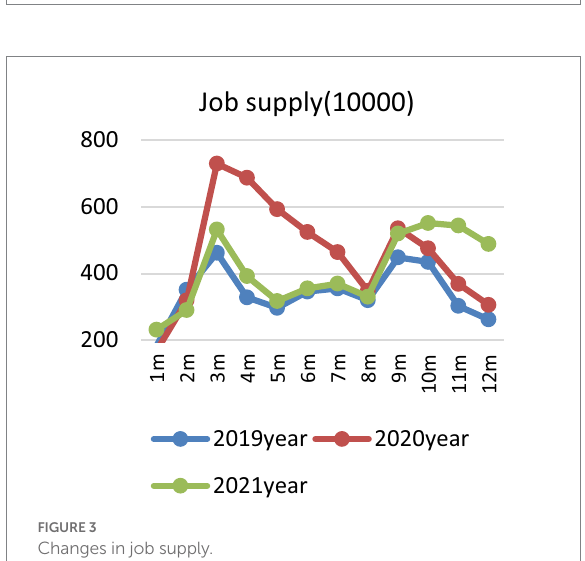
FIGURE 2 Changes in recruitment demand.